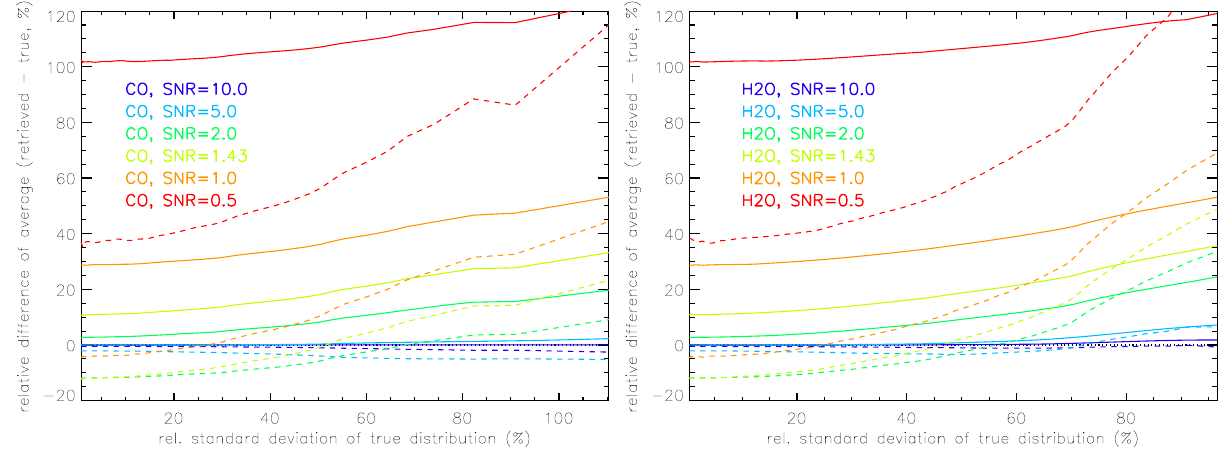
Fig. 5. Differences of retrieved and “true” zonal means (relative to the latter) versus local natural variaility in terms of standard deviation for the CO (left) and H 2 O (right). Solid: linear averages, dashed: logarithmic averages. Results are shown for maximum likelihood ln(vmr)- retrieval simulations with signal to noise ratios of 10 (dark blue), 5 (light blue), 2 (dark green), 1.43 (light green), 1.0 (orange), and 0.5